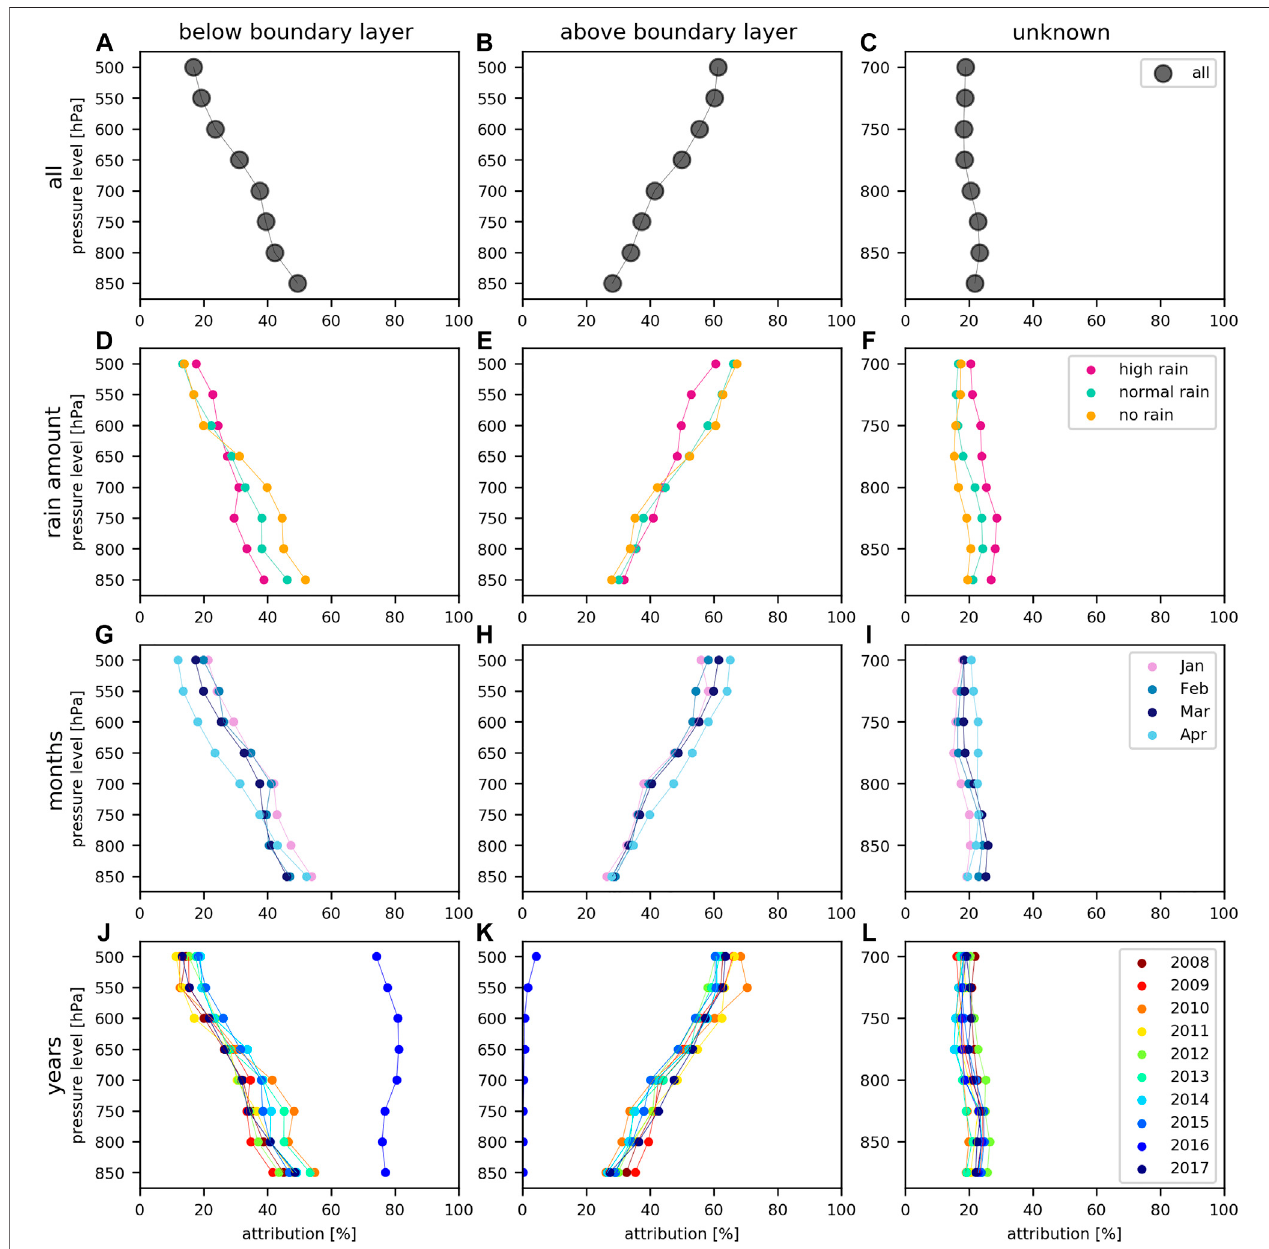
FIGURE5| Medianoftrajectoryattributionsseparatedbyeachgroup(belowboundarylayer,aboveboundarylayerandunknown)foreachpressurelevelandforall values (A – C) and separated for each composite [rain amount (D – F) , months (G – I) , years (J – L) ].